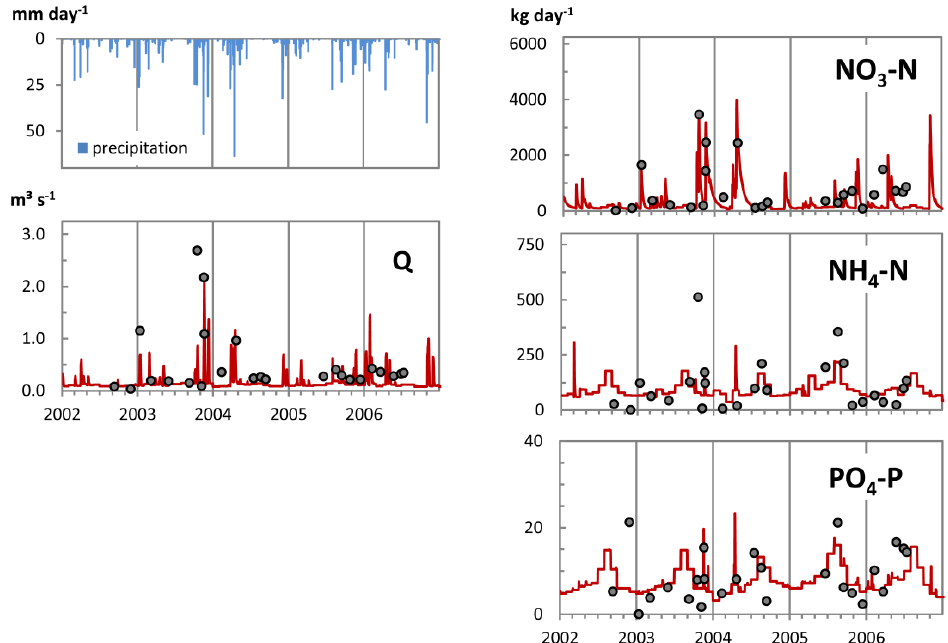
Figure 5. Comparison of simulated daily (red lines) and measured (dots) river discharge (Q), nitrate nitrogen (NO 3 -N), ammonium nitrogen (NH 4 -N) and phosphate phosphorus (PO 4 -P) loads for the catchment of the Albujon wadi (including the diversion from Rambla de la Maraña) and the simulation period